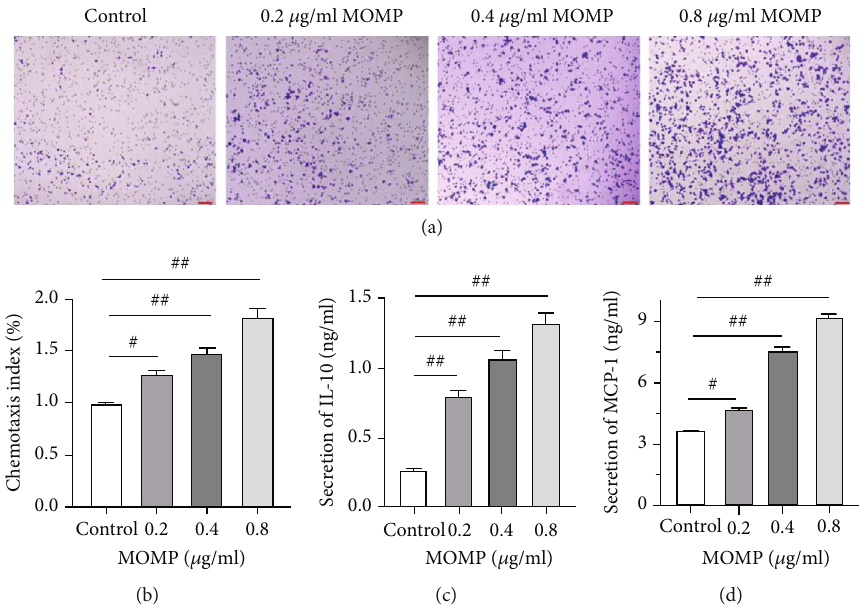
Figure 2: MOMP enhances the chemotaxis of RAW264.7 (a) The chemotactic potential of RAW 264.7 cells that migrated across the membrane in the MOMP-free medium, 0.2, 0.4, and 0.8 μ g/ml MOMP (crystal violet staining, original magni fi cation: 200x, scale bar = 100 μ m ). (b) Chemotaxis index of RAW 264.7. (c) Secretion level of IL-10 after the treatment of di ff erent doses of MOMP for 24 h. (d) Secretion level of MCP-1 after the treatment of di ff erent doses of MOMP for 24 h ( P < 0 : 05 , error bars = 95 % CIs.). The signi fi cant di ff erences were marked by a pound sign. P values: # P < 0 : 05 , ## P < 0 : 01